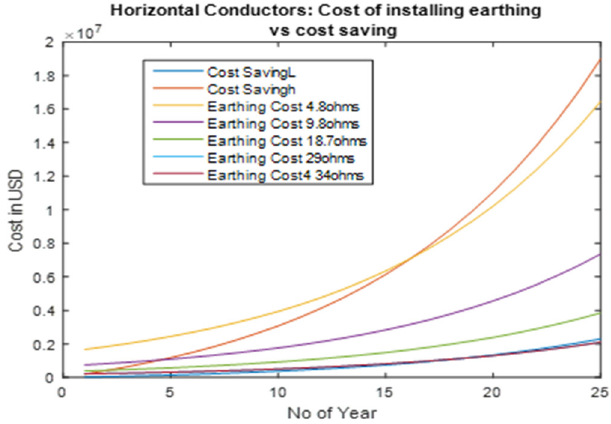
Figure 17. Earthing cost vs. cost saving.